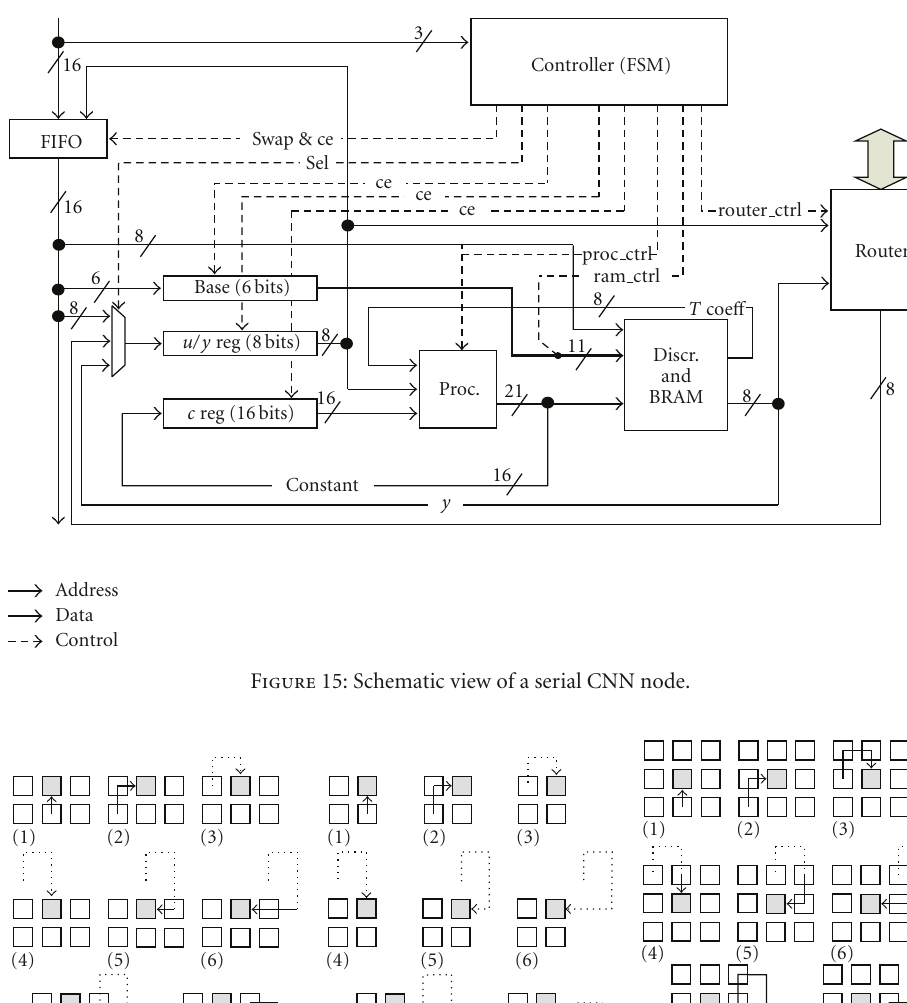
Figure 16: (a) Top edge, (b) right upper corner nodes, and (c) even close-to-boundary nodes have an incomplete communication cycle. Squares represent regular nodes; while the dotted lines show which part of the packet path is missing. The node of interest is shaded.